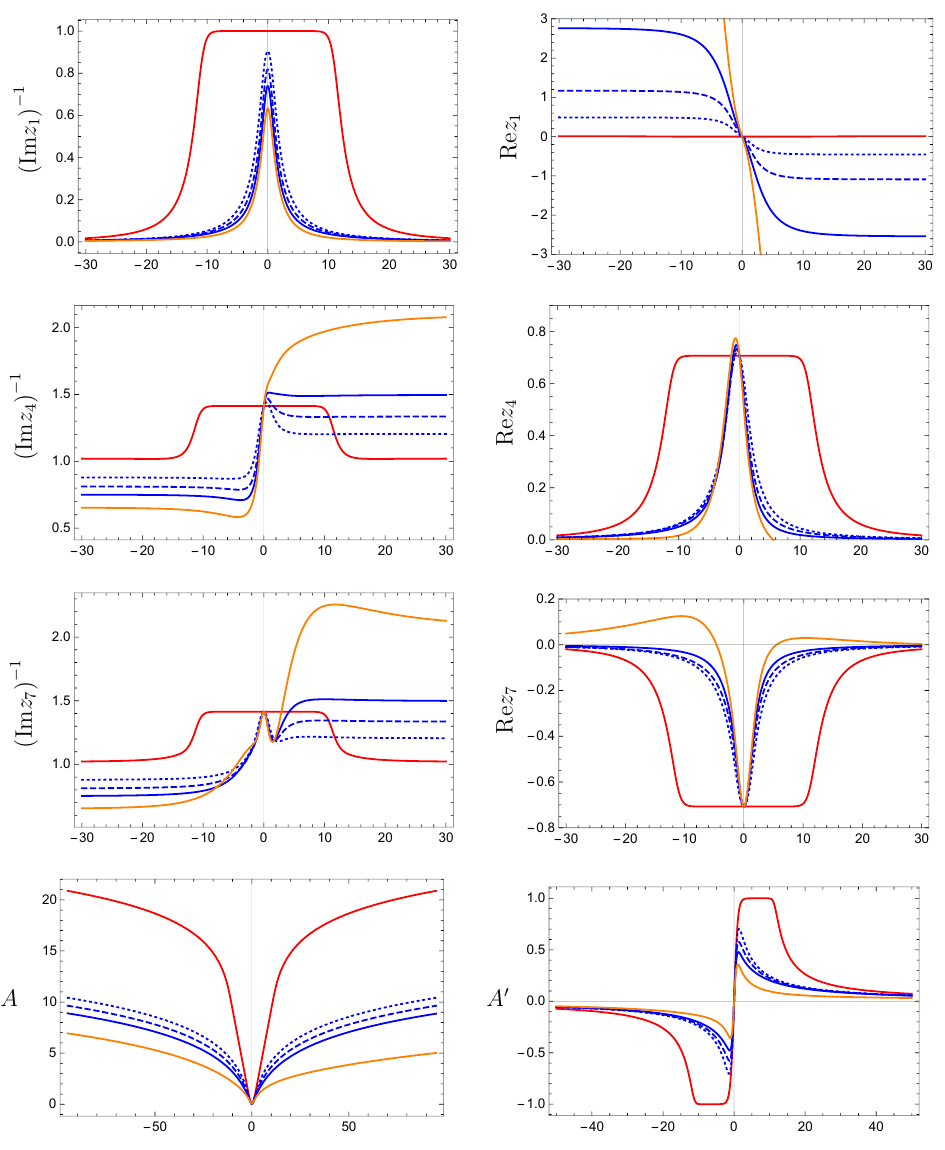
Figure 8 . Samples of regular flows within the SO(3) -invariant sector using the boundary condi- tions (3.34) for the complex scalar fields z